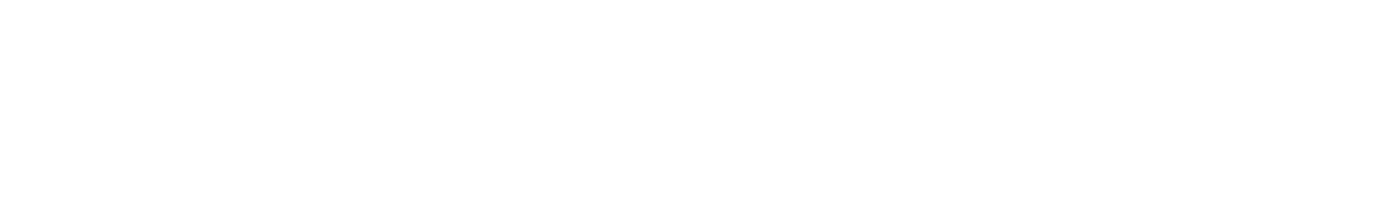
- FIGURE 8 Properties of Eq. (26) at v 1. The black lines are: f X + K- yv, f X + yv- bu(2v- e(1 + 3v2)); The blue curve is in accordance with the left-hand of Eq. (26), the red curve corresponds to the right-hand ofthe same equation. Other parameters are listed in Table